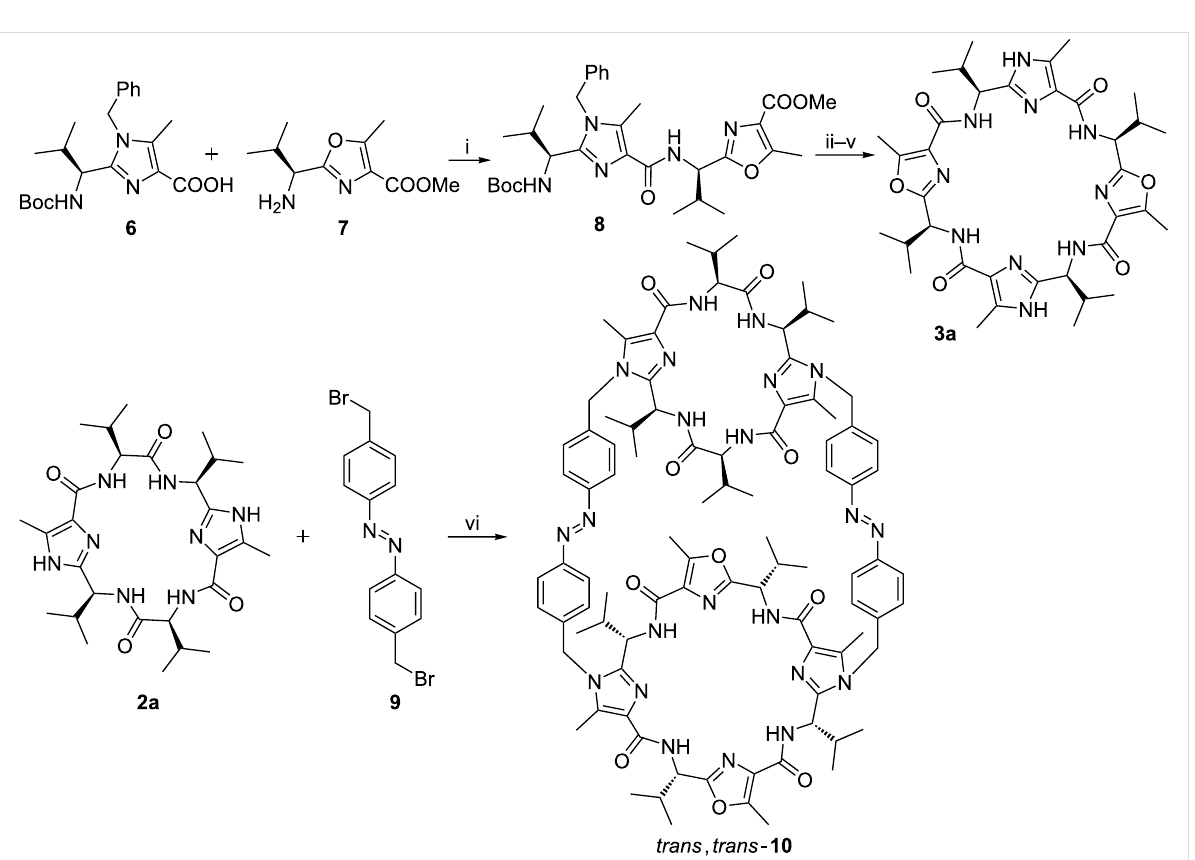
Scheme 1: Synthesis of the chiral foldable container 10 . Reaction conditions: i) FDPP, iPr 2 NEt, CH 3 CN, 90%; ii) MeOH, dioxane, NaOH, quant.; iii) EtOAc, HCl, quant.; iv) FDPP, iPr 2 NEt, CH 3 CN, 50%; v) MeOH, Pd(OH) 2 /C, H 2 , 95%; vi) 3a , K 2 CO 3 , CH 3 CN, Δ ,